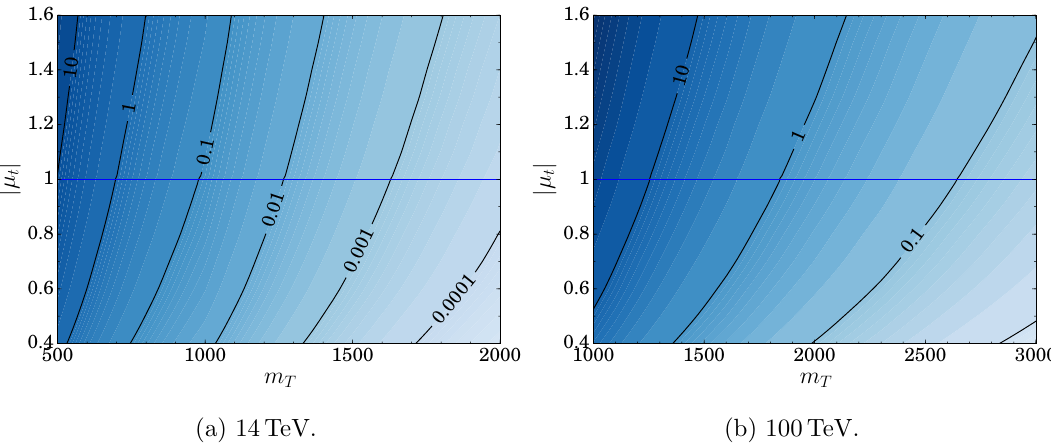
Figure 1. Cross section of the signal process TTh at 14 TeV a and 100 TeV b in fb as a function of the top partner mass m T and the absolute value of the naturalness parameter line at (cid:22) t = 1 indicates natural models. Note, that the production of TTh is not sensitive to the j j sign of (cid:22) t , hence all (cid:12)gures depend on For simplicity we ignore this uncertainty in the current analysis by (cid:12)xing the BRs to the values in relation